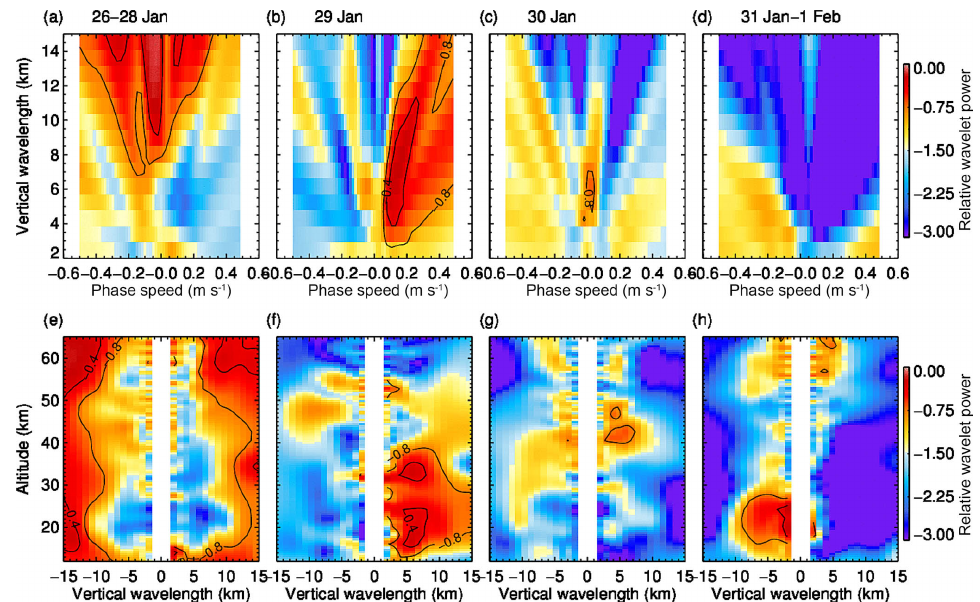
Figure 9. Relative wavelet power as a function of vertical wavelength λ z and vertical phase speed c Pz with respect to the background spectrogram for four time periods.